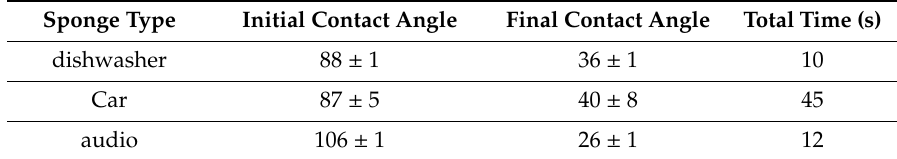
Table 4. Initial and final contact angle for 80% surfactant solution with distilled water on each sponge type, where the total process time is also shown.